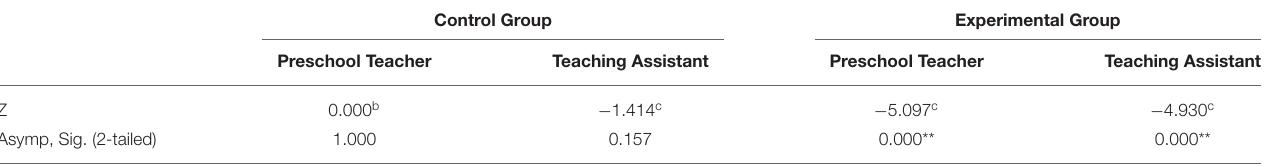
TABLE 6 | Comparison of Means Scores of Pre-test and Post-test in both Groups of